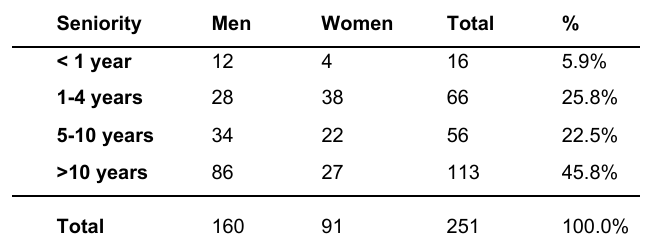
Table 2 . Seniority and